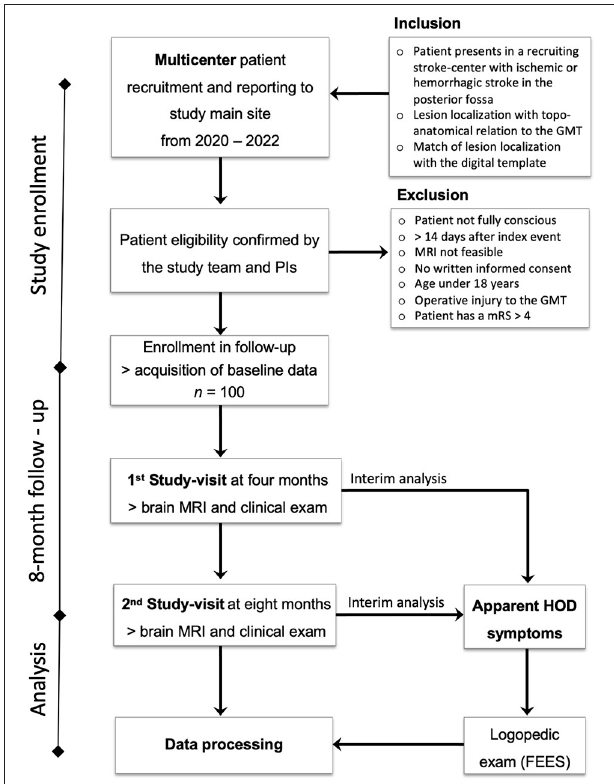
FIGURE 3 | Study design chart of the HOD-IS trial.